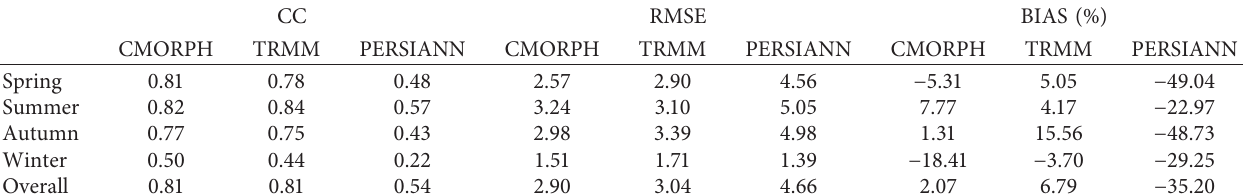
Table 3: The evaluation metrics of each satellite dataset in daytime.